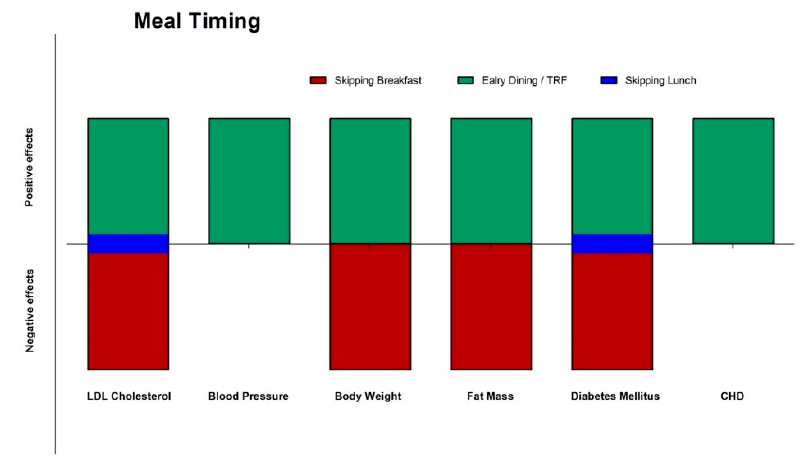
Figure 4. Effects (green: positive; red: negative; blue: neutral) of meal timing on different CVD risks factors and diseases. CHD: coronary heart disease; CVD: cardiovascular disease; TRF: time restricted feeding.